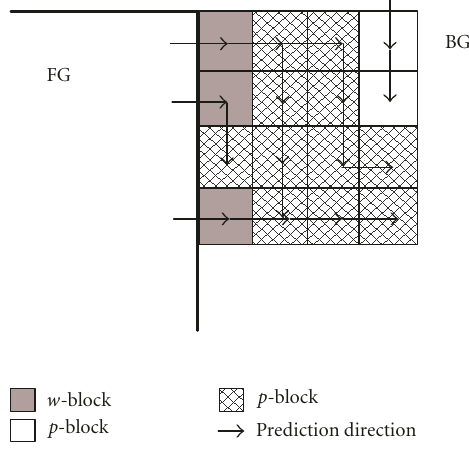
Figure 8: The wrong intrareference problem within a macroblock depending on the